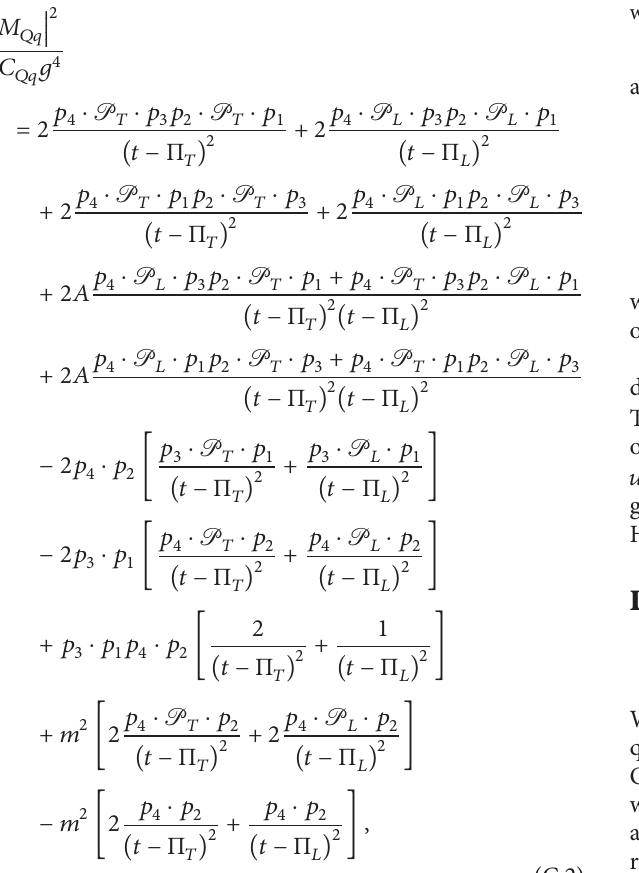
Figure 22: Variation of drag of heavy quarks of momentum 1GeV with temperature (color